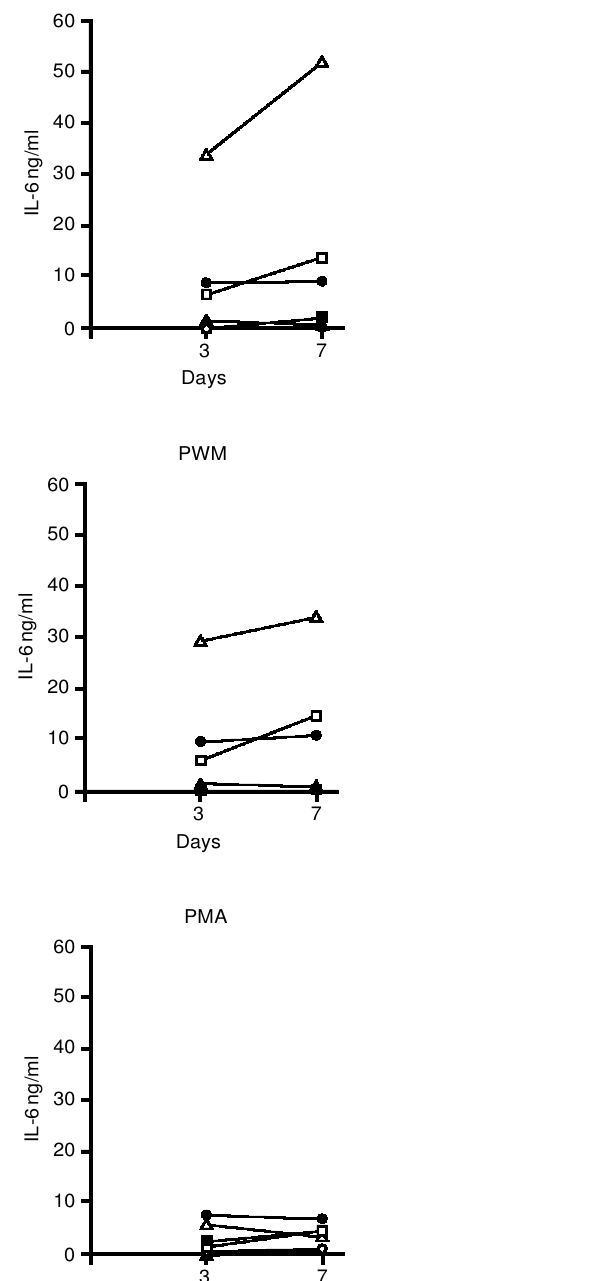
FIG. 1. The levels of IL-6 in supernatants from six B-CLL lymphocyte cultures after 3 and 7 days. The cells were either unstimulated (control) or stimulated with PMA (10 ng/ml) or PWM (10 m g/ml). FIG. 2. The levels of sIL-6R in supernatants from six B-CLL lymphocyte cultures after 3 and 7 days. The cells were either unstimulated (control) or stimulated with PMA (10 ng/ml) or PWM (10 m